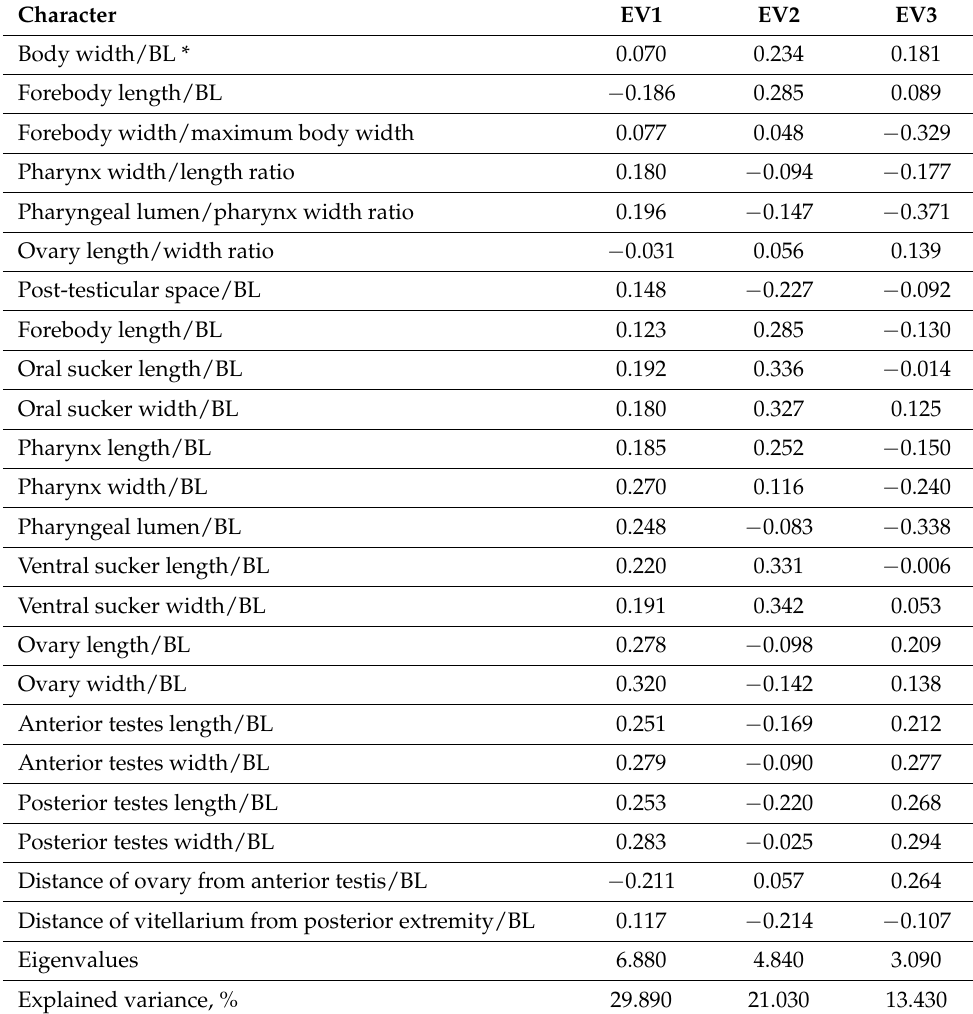
Table 2. Morphological characters, eigenvectors, and eigenvalues used for performing the multivari- ate analysis, including species Azygia lucii and A. sibirica n. sp.